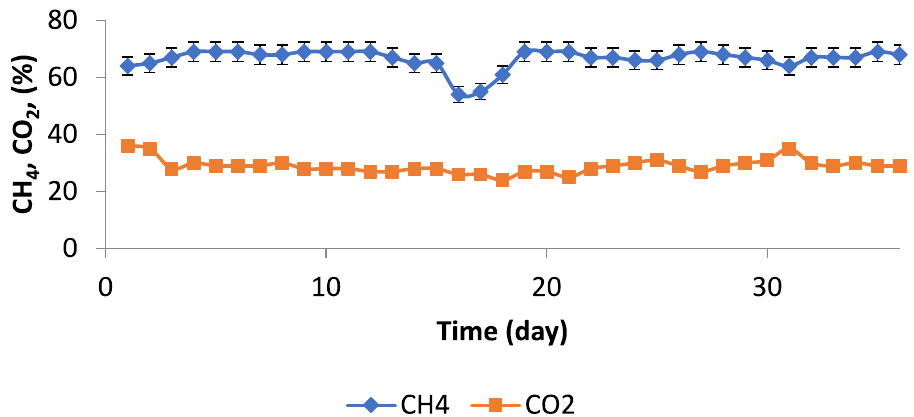
Figure 9. Volumetric content of CH 4 and CO 2 in BR 2 biogas in the continuous mode of TPAD of CSL.